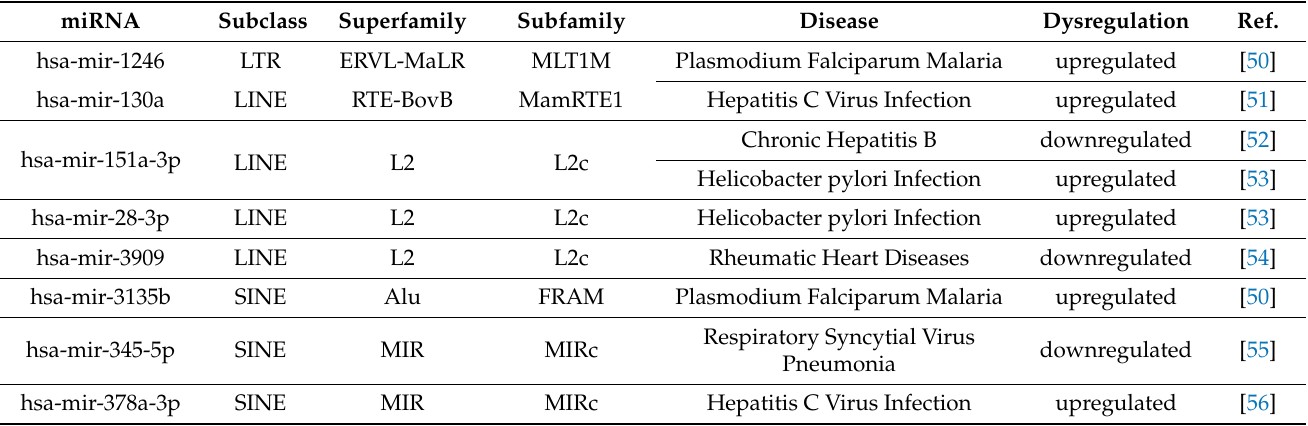
Table 1. MDTEs in relation to pathogen-associated